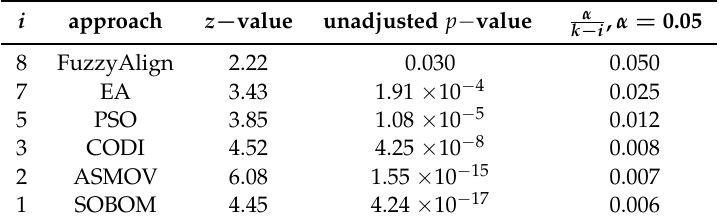
Table 3. Holm’s test on the alignment’s